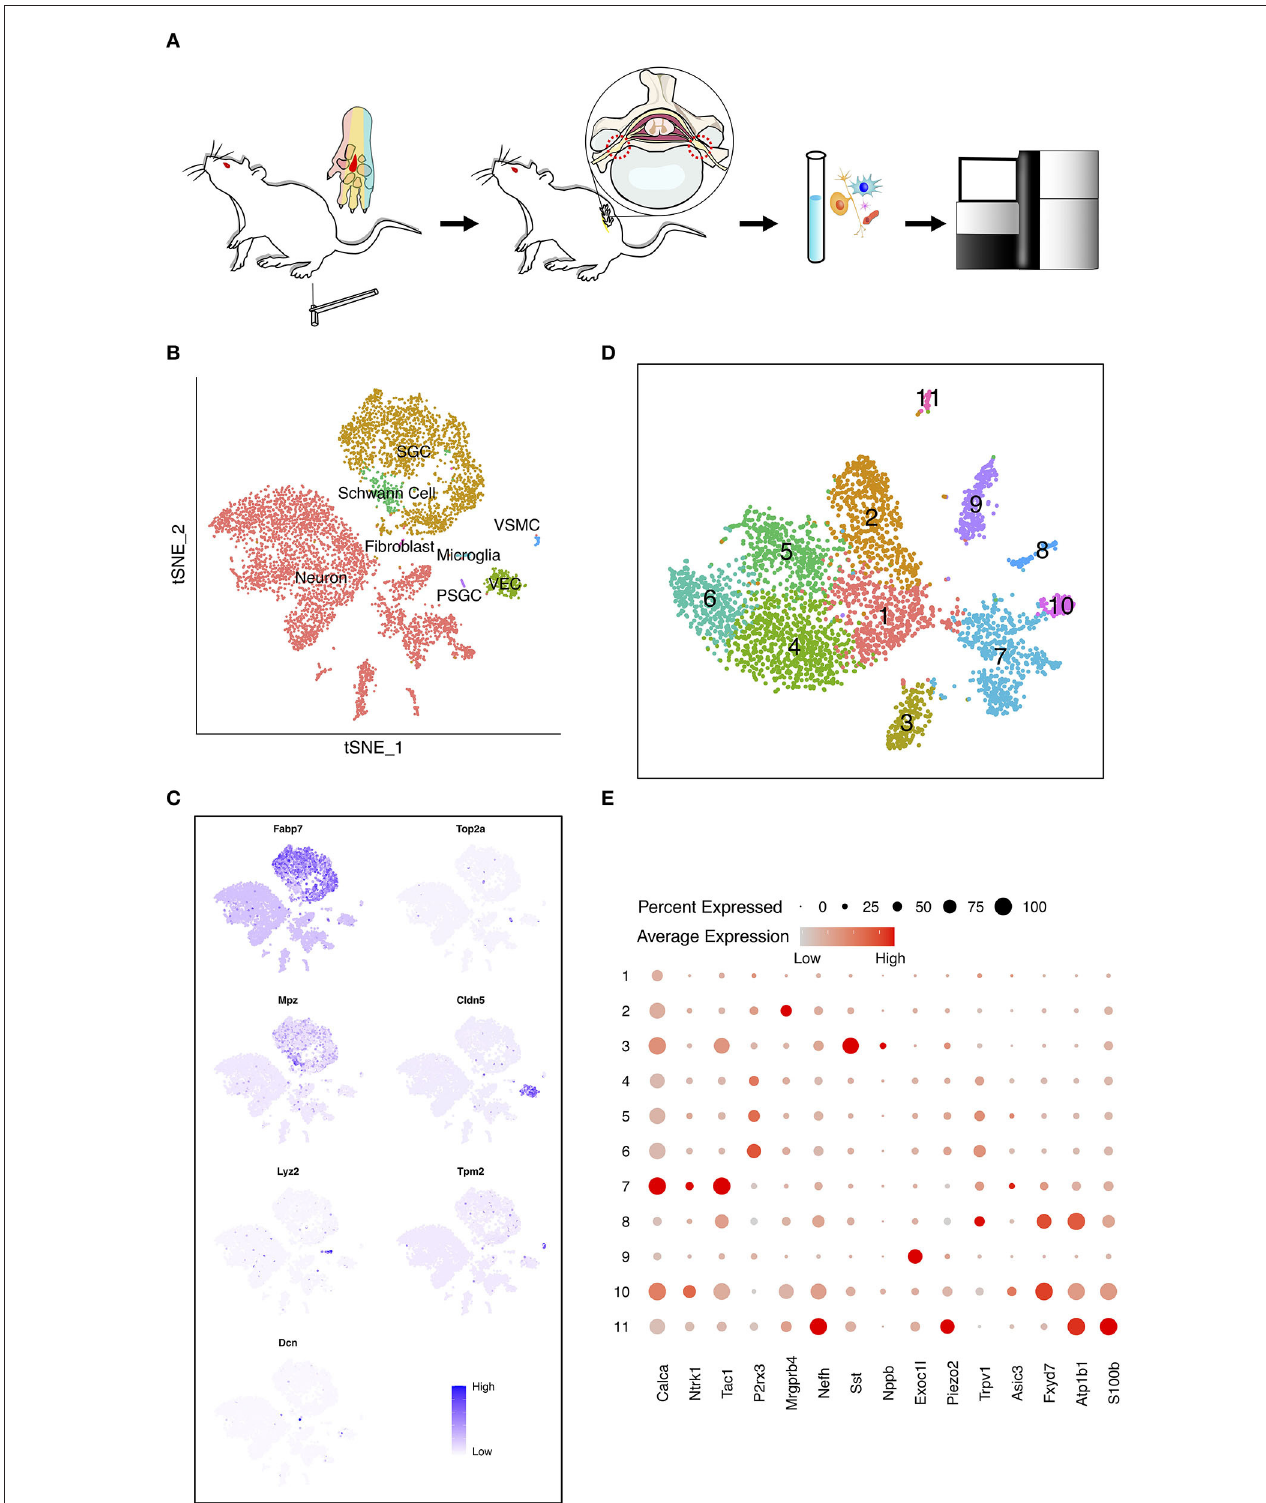
FIGURE 1 | The heterogeneity of dorsal root ganglia (DRG) cells in the painful diabetic peripheral neuropathy (PDPN) model. (A) Workflow of the pain threshold evaluation, sample preparation, sequencing, and bioinformatic analysis. The red region in the center of the rats’ paws was stimulated by von Frey filaments.